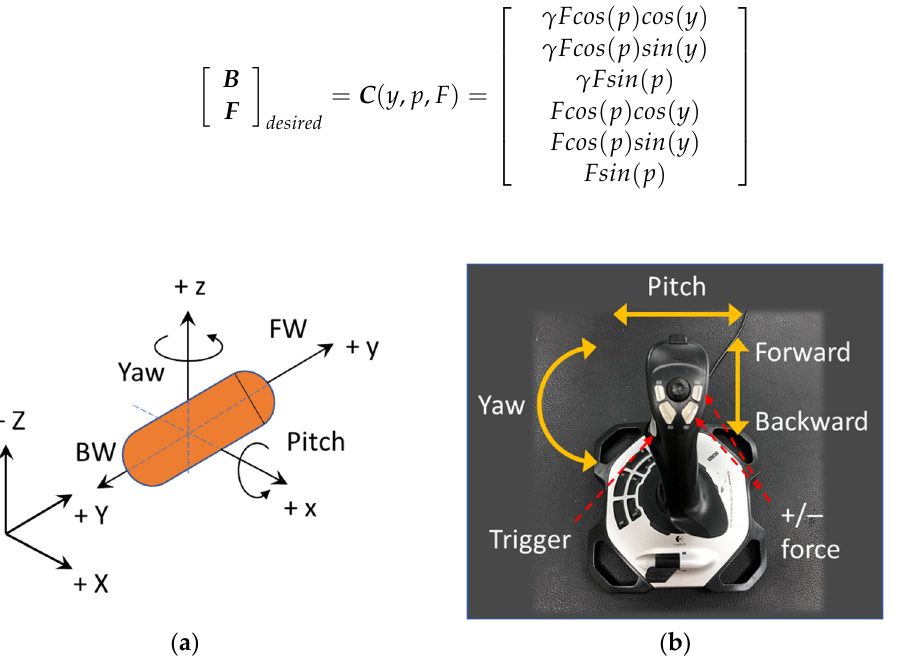
Figure 2. ( a ) Definition of controlled parameters of capsule endoscope and ( b ) mapped joystick functions. FW and BW stand for forward and backward, respectively.